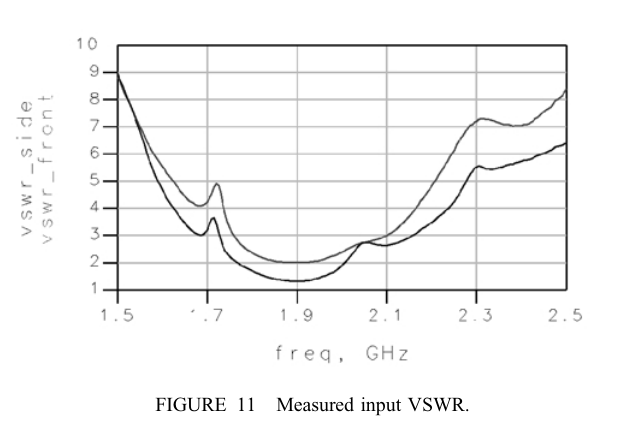
FIGURE 11 Measured input VSWR.